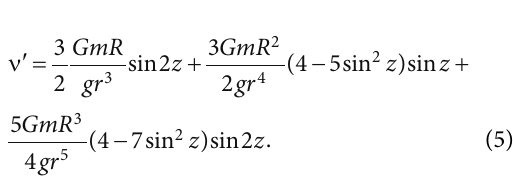
Fig. 1. Height difference